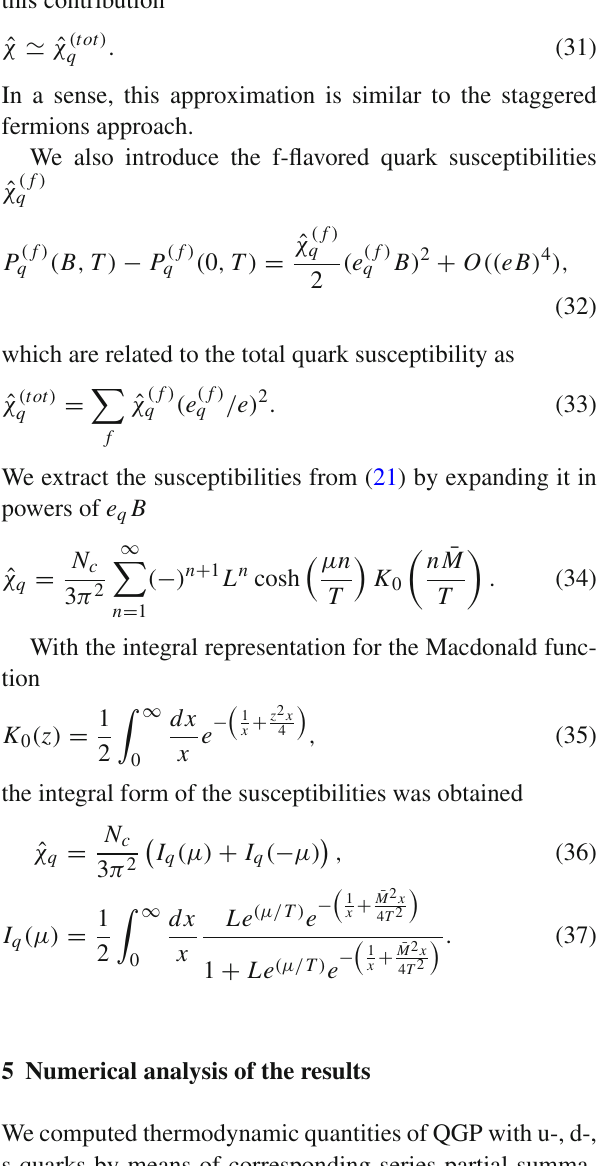
Fig. 2 The magnetic shift (cid:7) P = P ( eB ,μ) − P ( eB = 0 ,μ) for dense QGP with u, d, s quark flavors. For a given m.f., each trajectory demonstrates triple splitting for different μ B . the Solid lines are for μ = 0, the dash-dotted – for μ B μ = 0 . 4 B